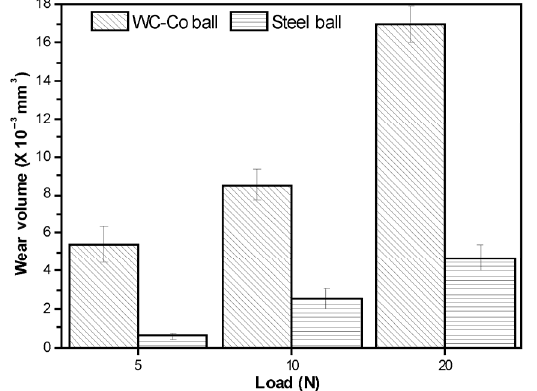
Fig. 6 Wear volume of SiC ceramics as function of load against WC-Co and steel counterbodies.